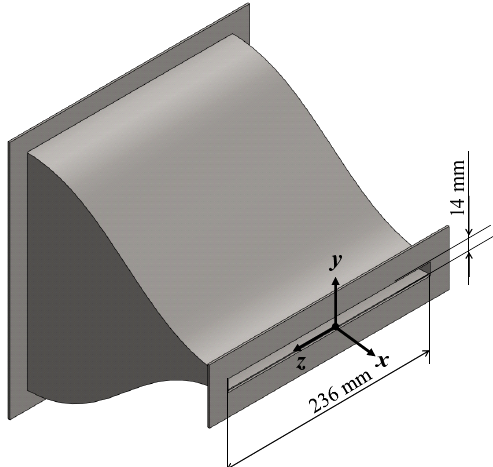
Fig. 11 Schematic view of the contraction nozzle and the coordinate